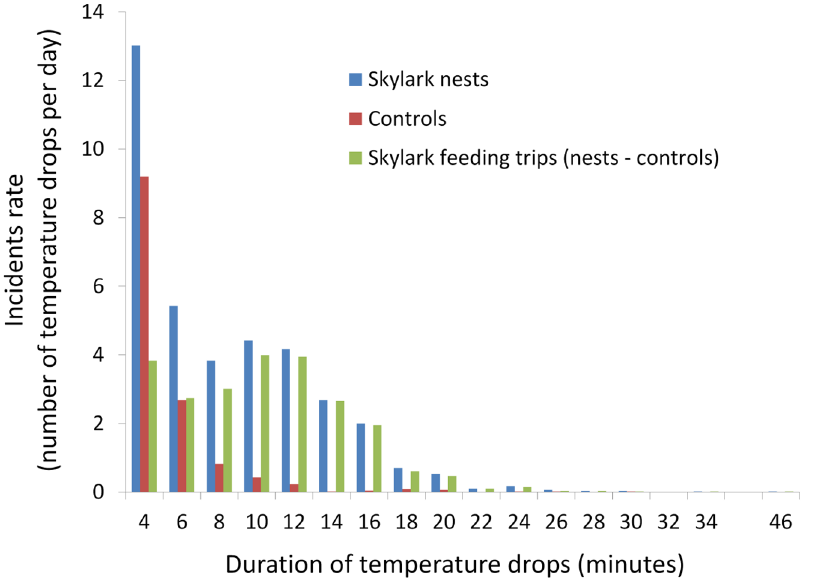
Figure 7. Frequency distribution of the length of temperature drops measured with temperature loggers placed in seven skylark nest and two control locations in the Kalø study area during the breeding season 2005 on which the frequency distribution of the length of foraging trips of incubating females was estimated.